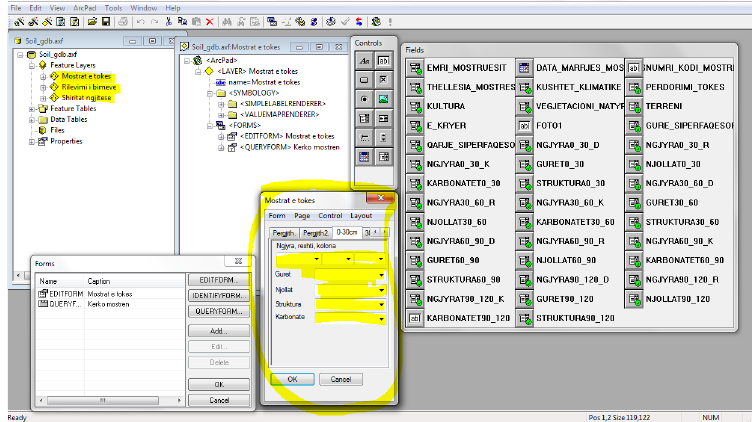
Figure 6. The GIS mobile